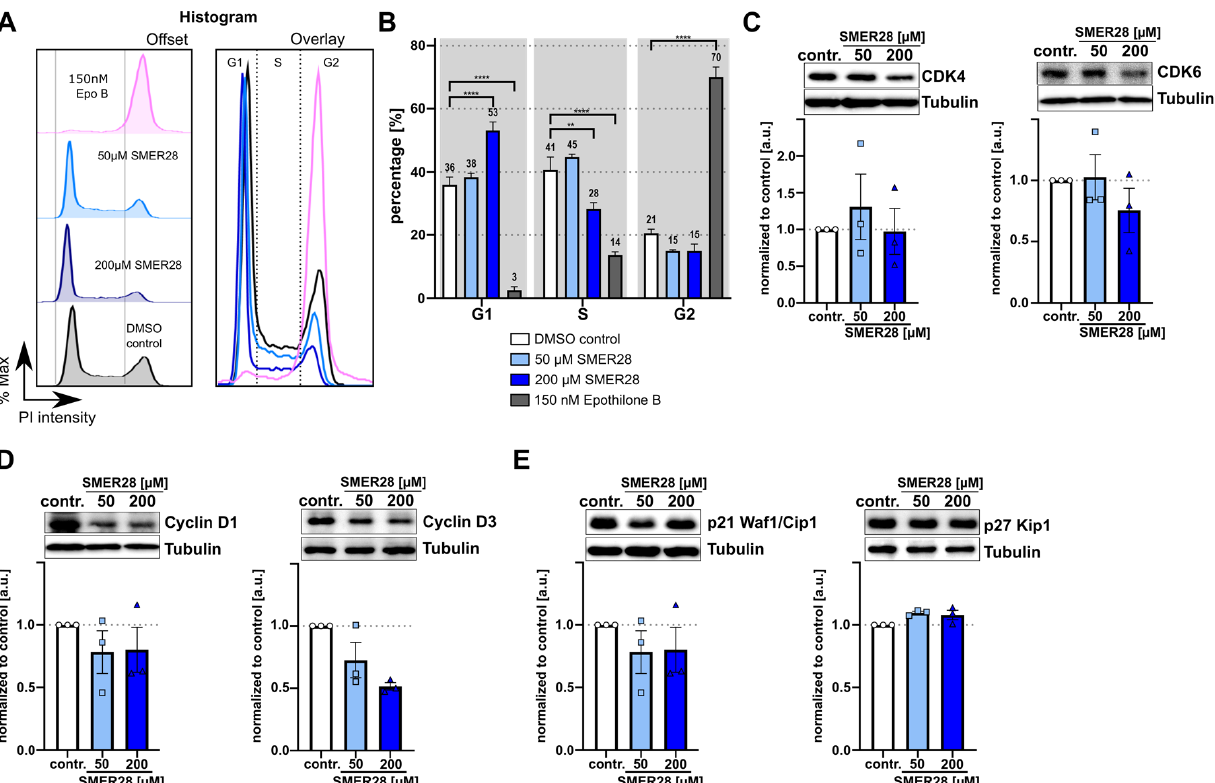
Figure 3. SMER28 treatment induces G1 cell cycle arrest. ( A , B ) Flow cytometry analysis of cell cycle distributions using PI (propidium iodide) staining after 24 h incubation of U-2 OS cells with different concentrations of SMER28 or epothilone B, as indicated. ( A ) Representative histograms depicting the distributions of cell cycle phases for indicated treatments. Histograms are shown as offset (left) and overlay (right). ( B ) Bar plots showing respective percentages of cell cycle phases (G1, S and G2) according to PI intensities. Percentage of each cell cycle phase was calculated by Watson Pragmatic model using FlowJo software. Data are means from at least three independent experiments ± s.e.m. ** p < 0.01, **** p < 0.0001, two-way ANOVA. ( C – E ) U-2 OS cells treated with 50 or 200 µ M of SMER28 were lysed in Laemmli buffer after 24 h. Protein expression levels of CDK4 and CDK6 ( C ), Cyclin D1 and Cyclin D3 ( D ) as well as p21/Cip1 and p27/Kip1 ( E ) were assessed by WB. Bar graphs show protein levels calculated relative to tubulin. Data are means ± s.e.m; n =